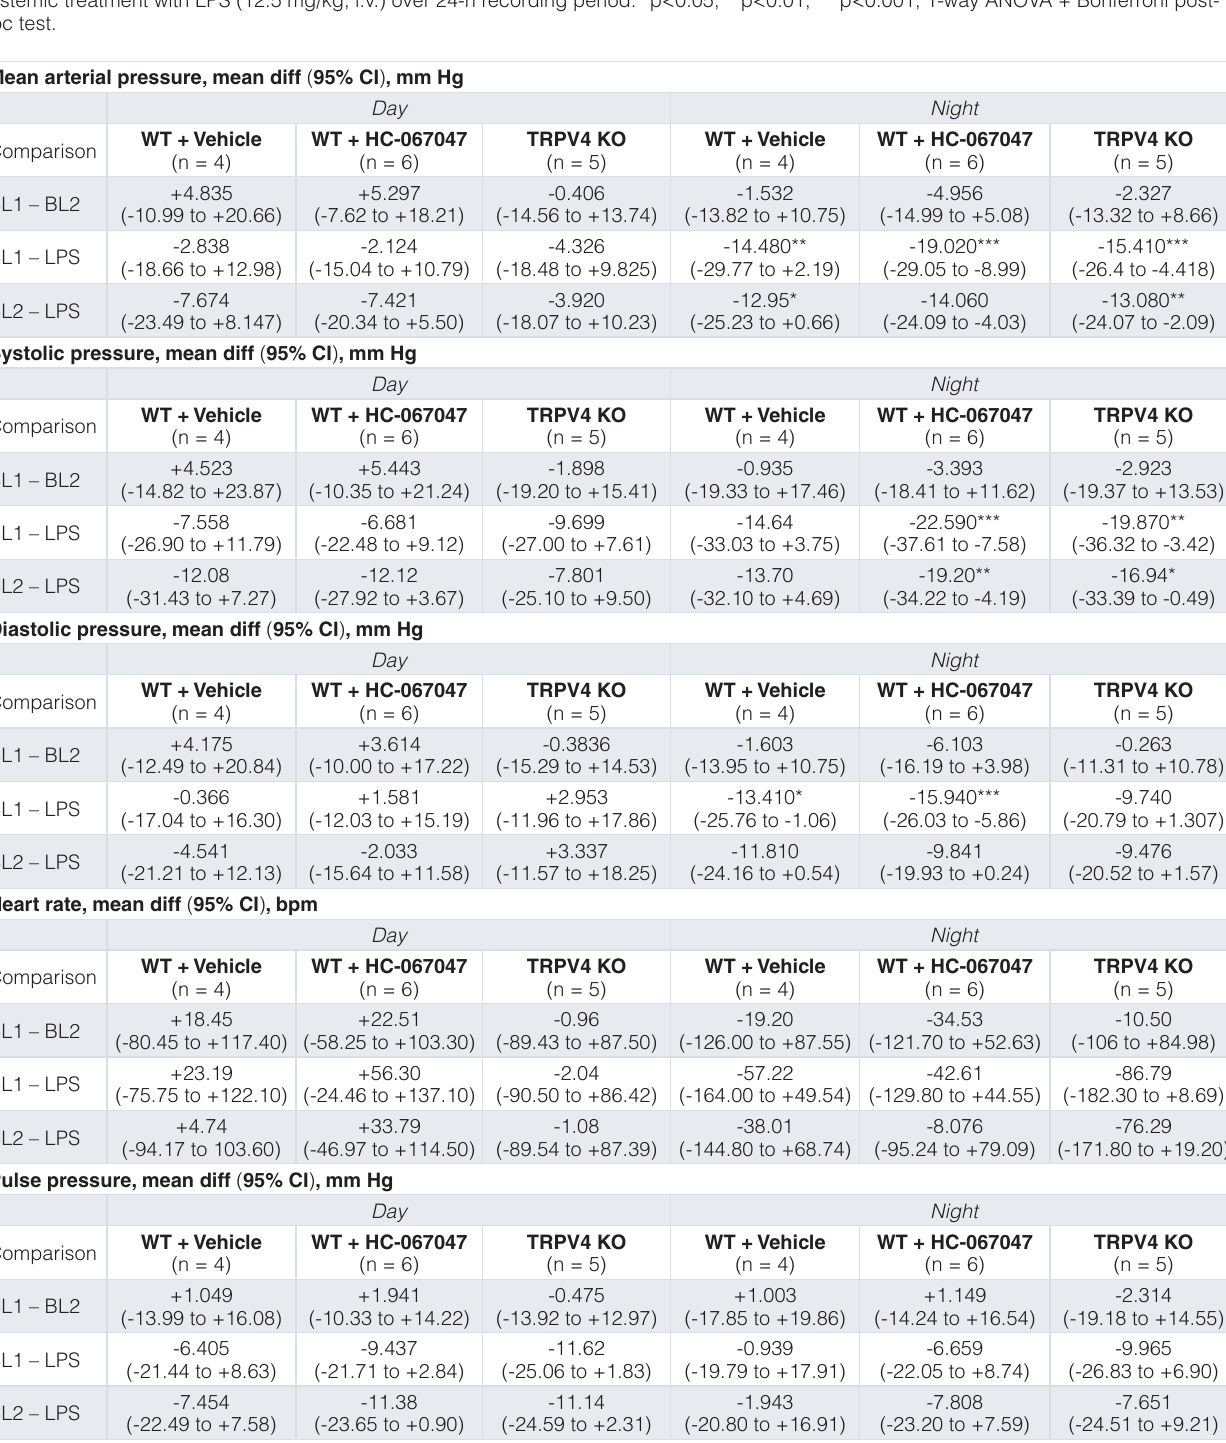
Table 1. Statistical comparison of haemodynamic parameters in TRPV4 WT and KO mice under basal and endotoxaemic conditions. Data are presented as mean difference (95% CI), and are divided into daytime and night-time phases. BL1 represents mean baseline values in untreated mice over 48-h weekend recording. BL2 represents mean baseline values following i.p. treatment (WT mice only) with vehicle (10% DMSO) or HC-067047; BL2 in KO mice represents a separate untreated 48-h baseline recording. LPS represents mean values following systemic treatment with LPS (12.5 mg/kg, i.v.) over 24-h recording period. *p<0.05, **p<0.01, ***p<0.001, 1-way ANOVA + Bonferroni post- hoc